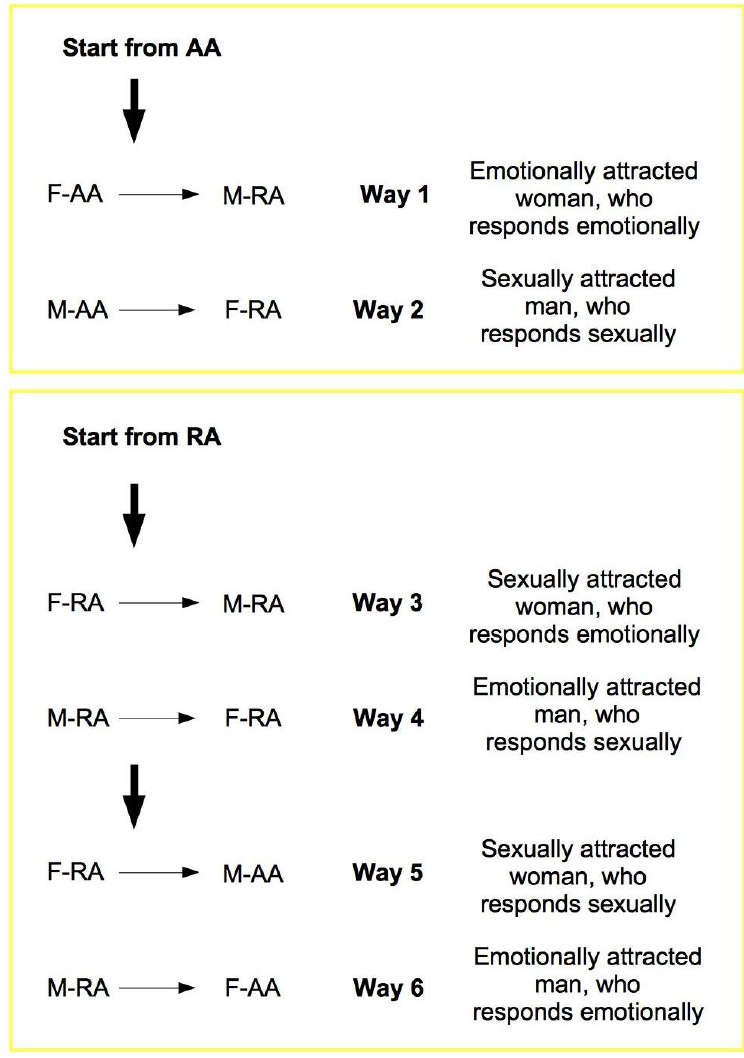
Figure 11. Summary scheme for the six Ways.